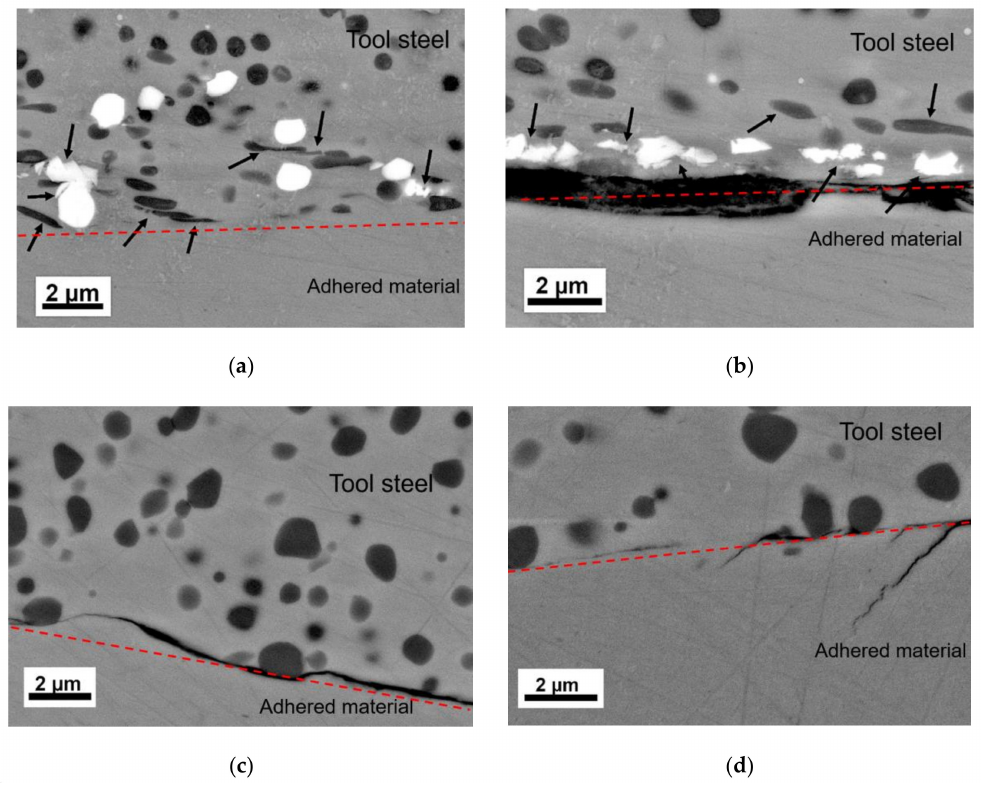
Figure 10. SEM images of the cross-section of the worn tools tested at 500 N (1.65 MPa) and 450 strokes against CP1180HD sheet: ( a ) V40, ( b ) V40, ( c ) VSC and ( d ) V8SC. Arrows indicate the deformed and fractured hard phase